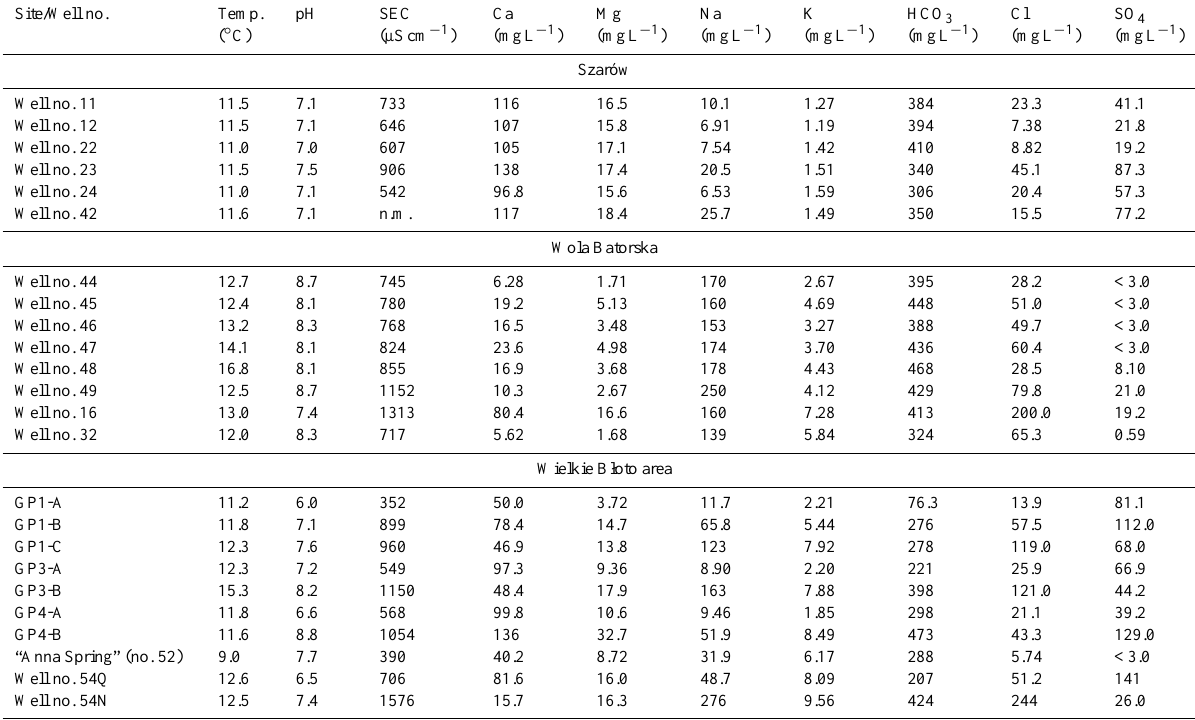
Table 2. Physico-chemical parameters of groundwater samples collected in the study area (n.m.: not measured). Site/Well